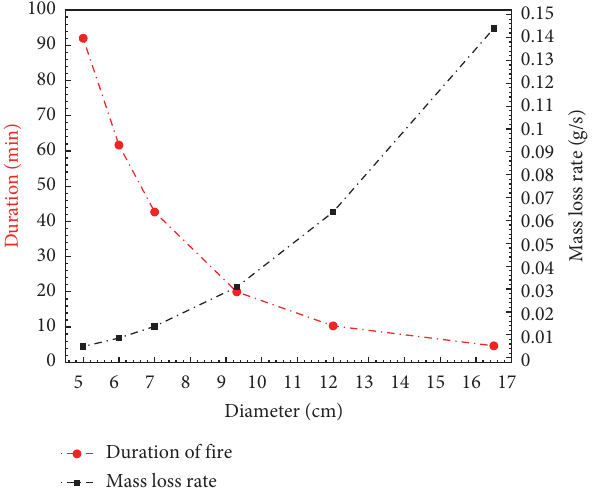
Figure 10: Variation of the fire duration and mass loss rate of fuel according to the source: case of confined tests.